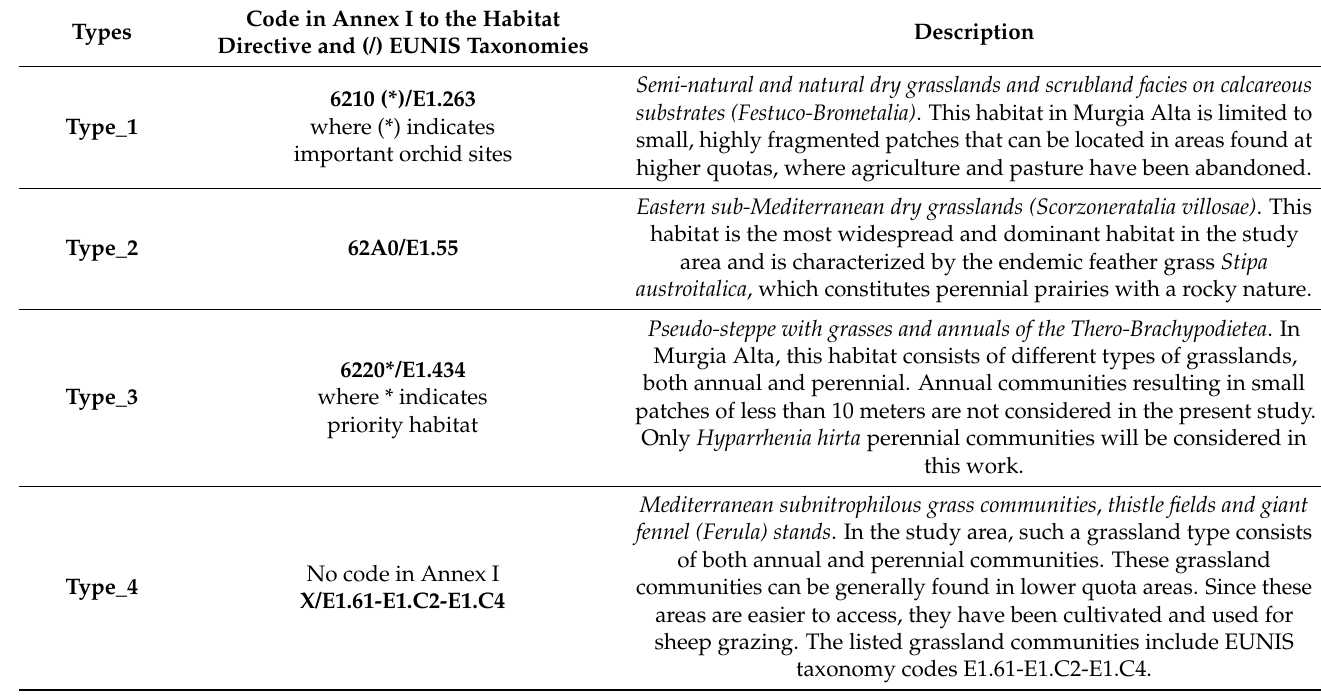
Table 1. Annex I and specific EUNIS codes for grassland habitat types in “Murgia Alta”